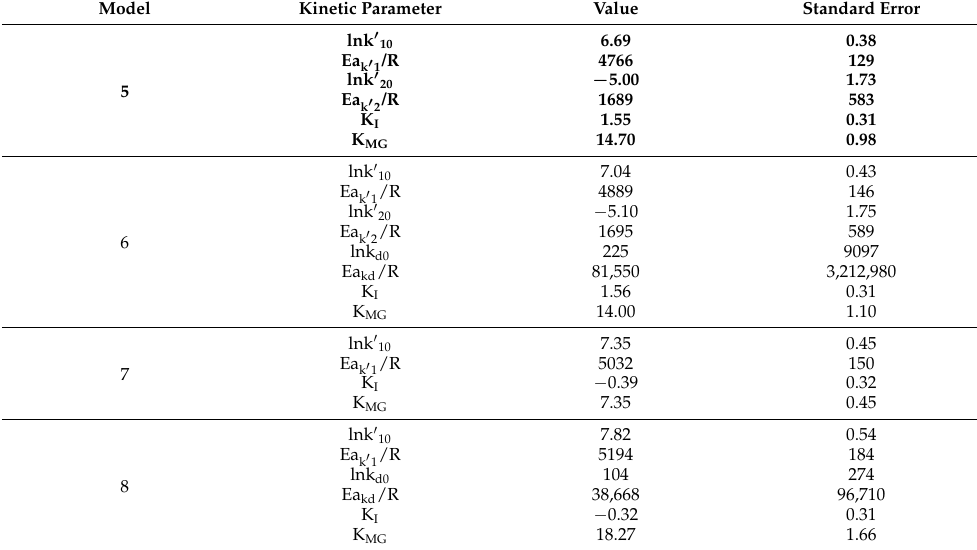
Table 8. Parameter values, with standard error, of the proposed kinetic models of glycerol esterifi- cation with ibuprofen for the triphasic L-L-S system with toluene as apolar cosolvent and water as polar cosolvent. The selected model parameters are indicated in bold font. Model Kinetic Parameter